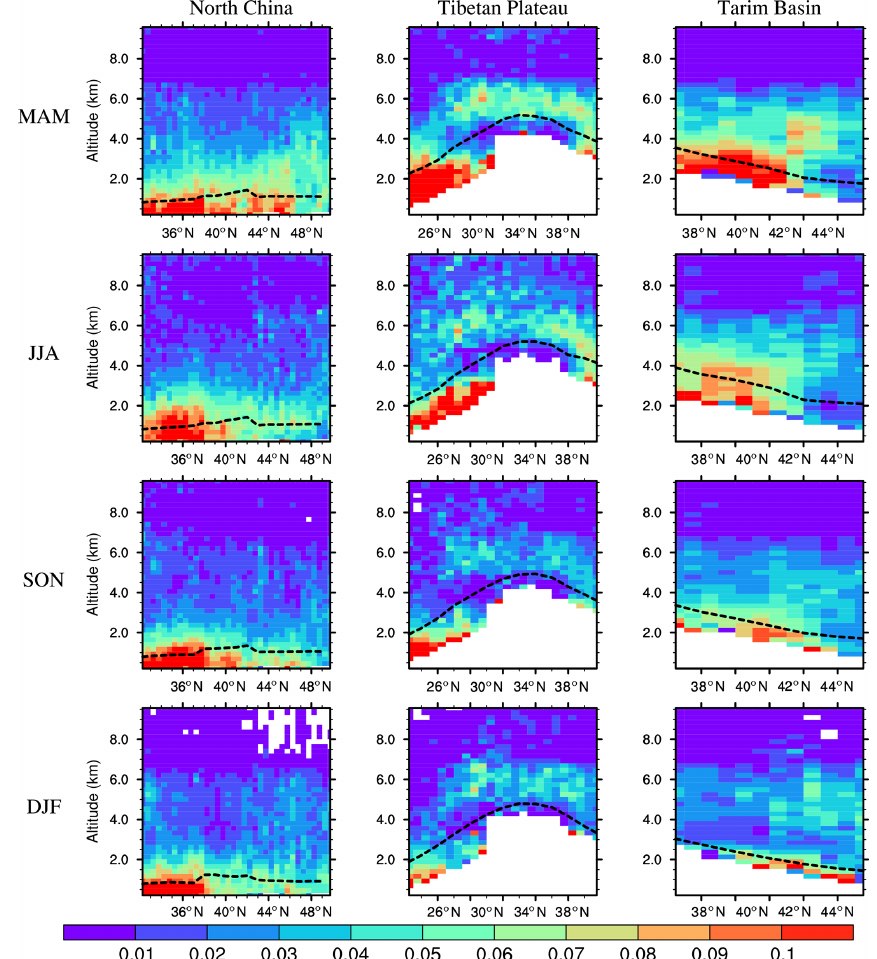
Figure 4. Vertical structure of the 1064nm aerosol extinction coefficients (km − 1 ) observed from CATS by season over the three regions in relation to the zonal mean regional surface altitude. The dotted lines represent the height of the zonal mean regional planetary boundary layer (km) from the NCEP FNL reanalysis